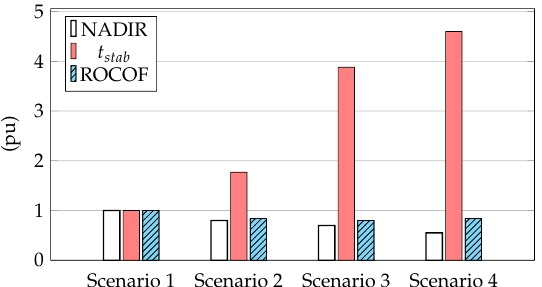
Figure 19. NADIR, stabilization time and ROCOF: comparison for the different Figure 19. Nadir, stabilization time and ROCOF: comparison for the different scenarios considering scenarios considering ∆ P L = 0.050 and including wind power plant control ∆ P L = 0.050 and including wind power plant control from [23]. from [24]